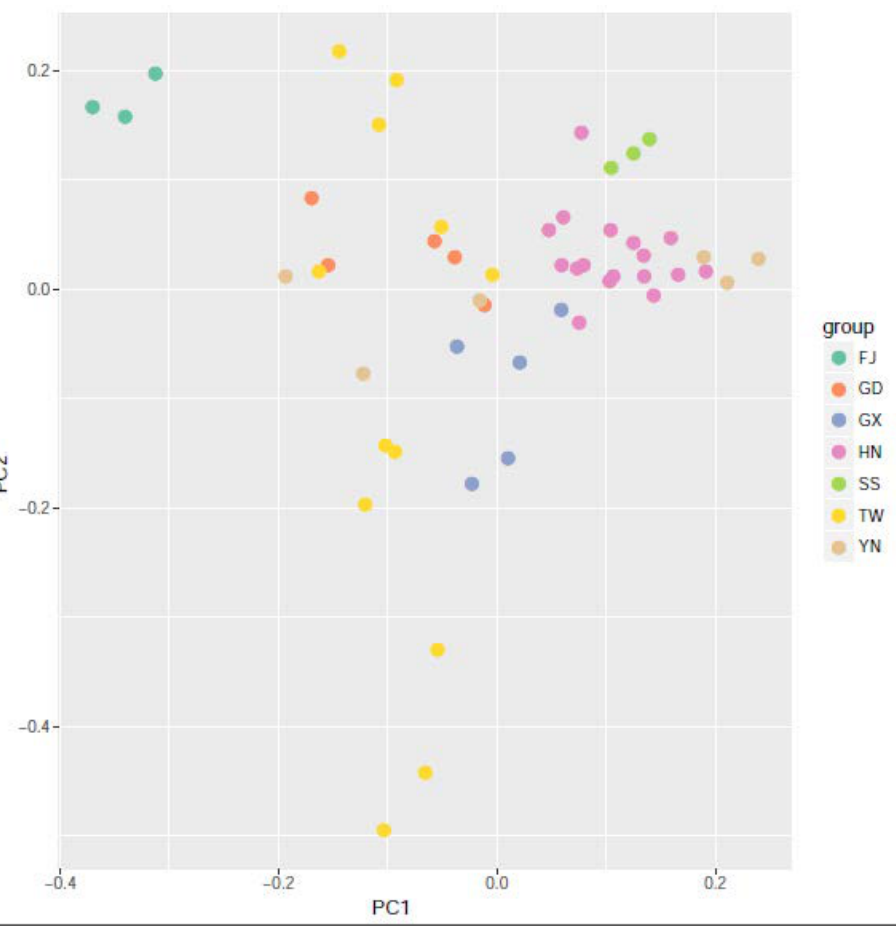
Figure 3. Determination of K using STRUCTURE.